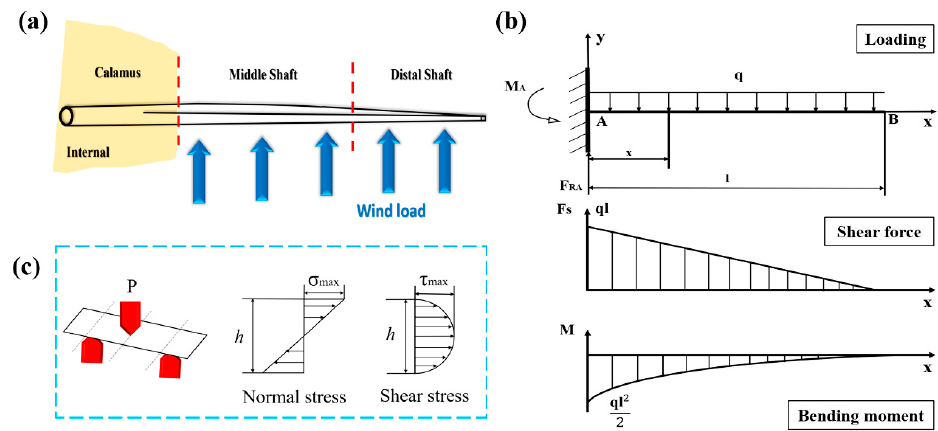
Figure 6. ( a ) The daily load pattern of the feather shaft, ( b ) schematic diagram for distribution of load, shear force and bending moment in feather shaft under wind load and ( c ) normal and shear stress distribution in flexural samples.